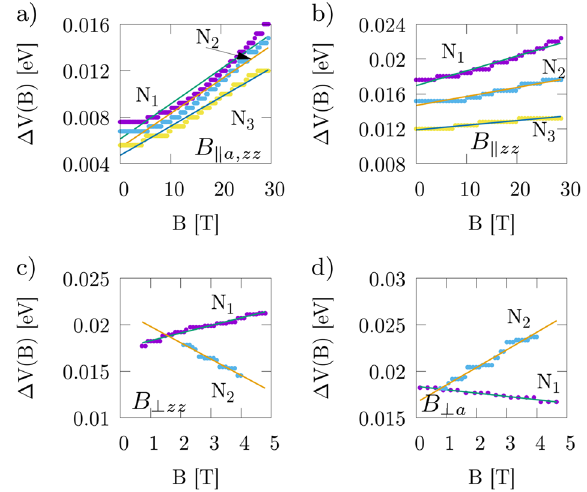
( a ) without SO and ( b ) with SO (cid:31)